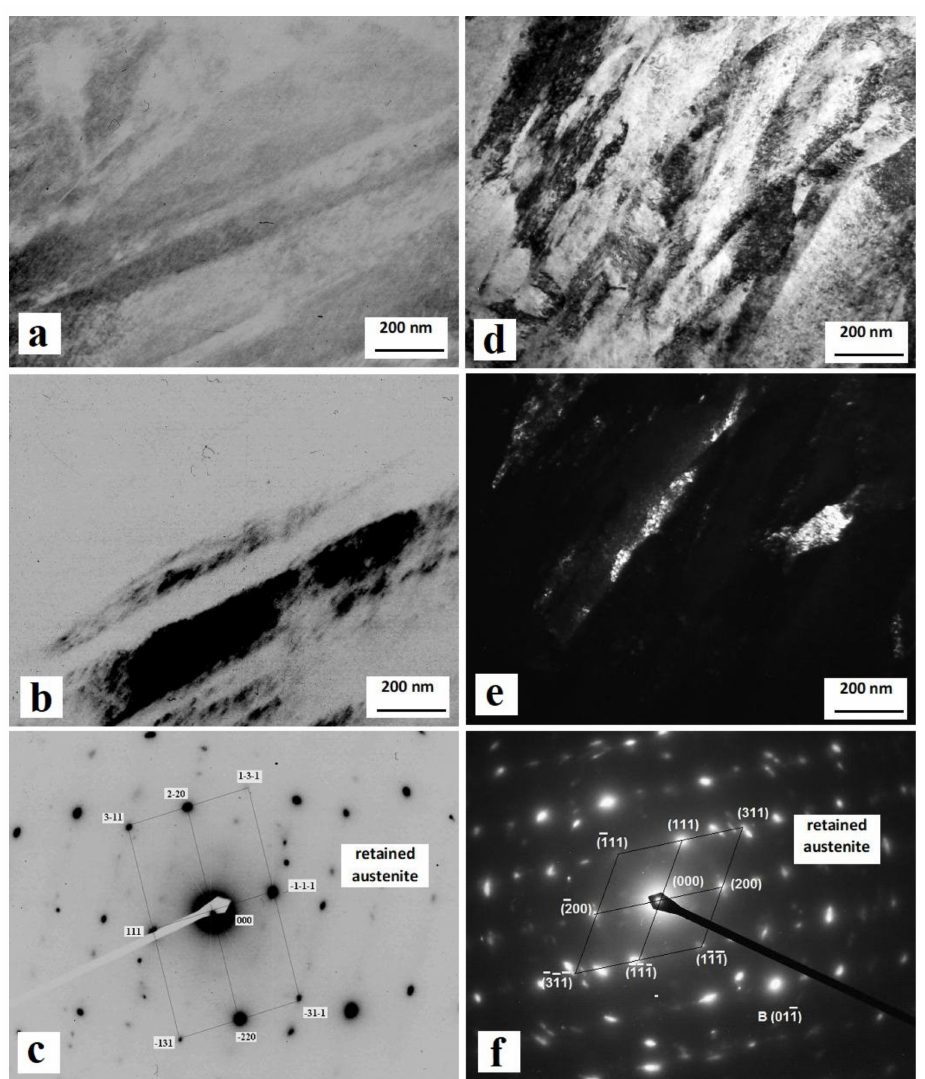
Figure 4. Transmission electron microscopy (TEM) micrographs of the CHT specimen ( a – c ) and the specimen that was subjected to SZT at − 196 ◦ C ( d – f ). ( a ) Bright-field image showing martensitic needle microstructure with retained austenite at needle interfaces, ( b ) corresponding dark-field image showing the retained austenite, ( c ) diffraction patterns of the retained austenite, ( d ) bright- field image showing martensitic microstructure with a small amount of retained austenite at the interfaces of martensitic domains, ( e ) corresponding dark-field image, ( f ) diffraction patterns of the retained